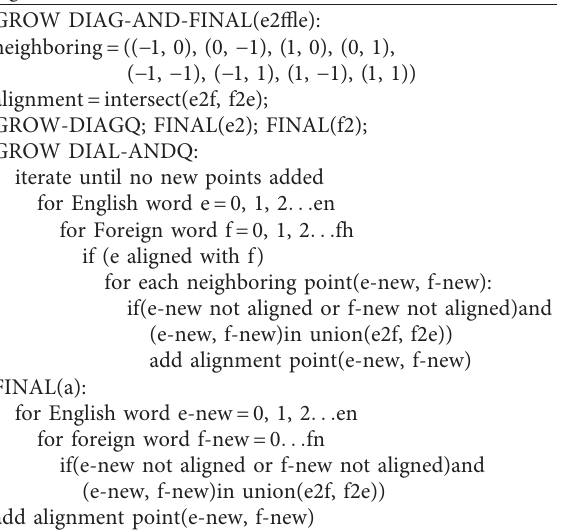
Table 2: Pseudocode for grow-diag-and-final heuristic word alignment extension. GROW